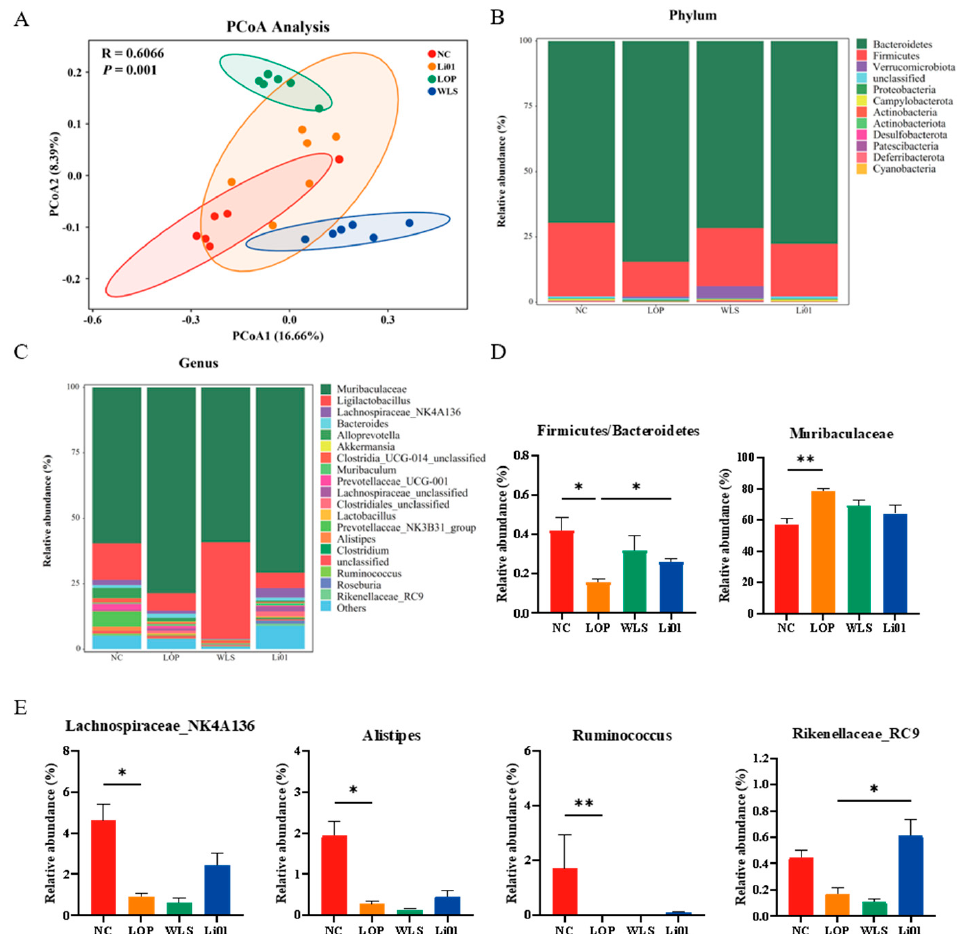
Figure 5. Alteration of the gut microbiota composition of mice in the normal, control group (NC), loperamide-induced constipation group (LOP), Weileshu probiotic group (WLS), and Ligilactobacillus salivarius Li01 group (Li01). The relative abundance of the gut microbiota at the phylum level ( A ) and the genus level ( B ) is shown for the different groups. ( C ) β -diversity was evaluated by a principal components analysis (PCoA) of unweighted unifrac distance. ( D , E ) The gut microbiota composition of mice in the NC group and the LOP group detected by 16S rRNA gene sequencing. Data are presented as mean ± SEM, n = 6. Significant differences are denoted by * ( p < 0.05), and ** ( p <